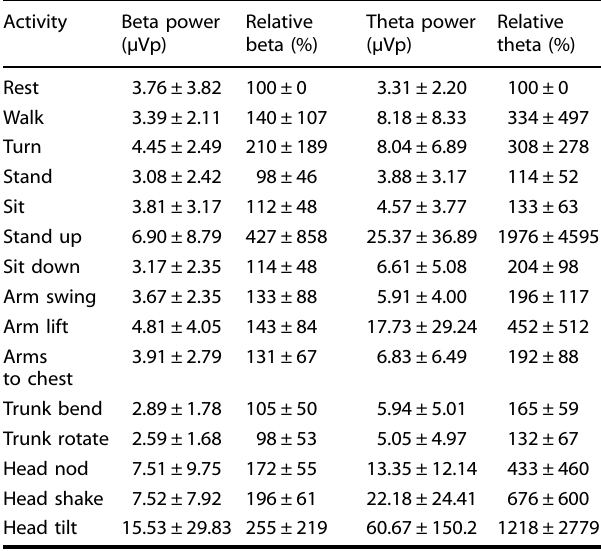
Table 1. Common movements and their impact on measured beta and theta